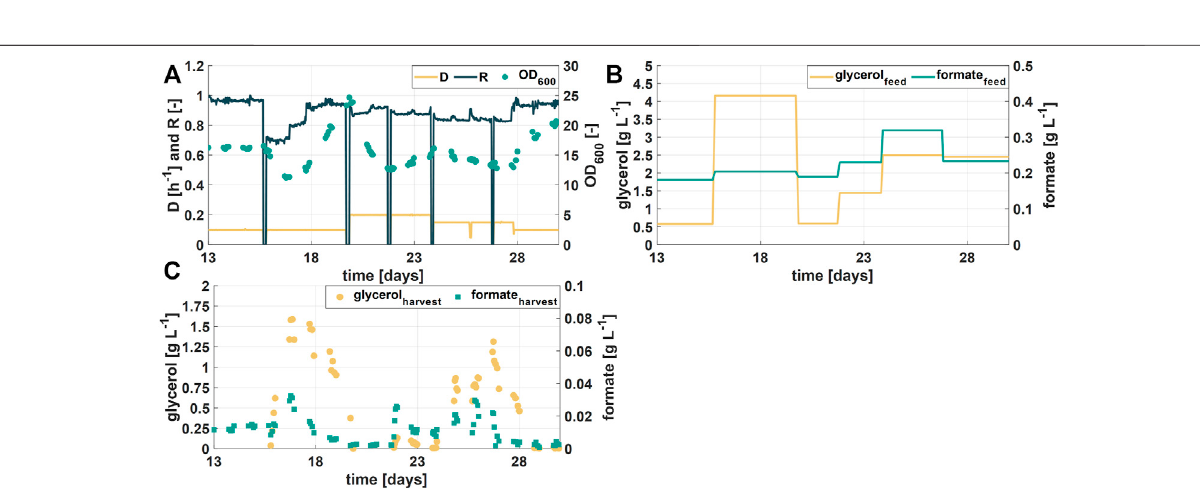
FIGURE 4 | Process performance during the second experimental phase (A) Optical density (OD 600 ) during the cultivation time of the second phase (17 days). Process parameters (dilution rate D and retention rate R) were changed to maintain a stable biomass concentration (B) Feed concentrations of the additional substrate glycerol and formate (C) Concentration of glycerol and formate in harvest